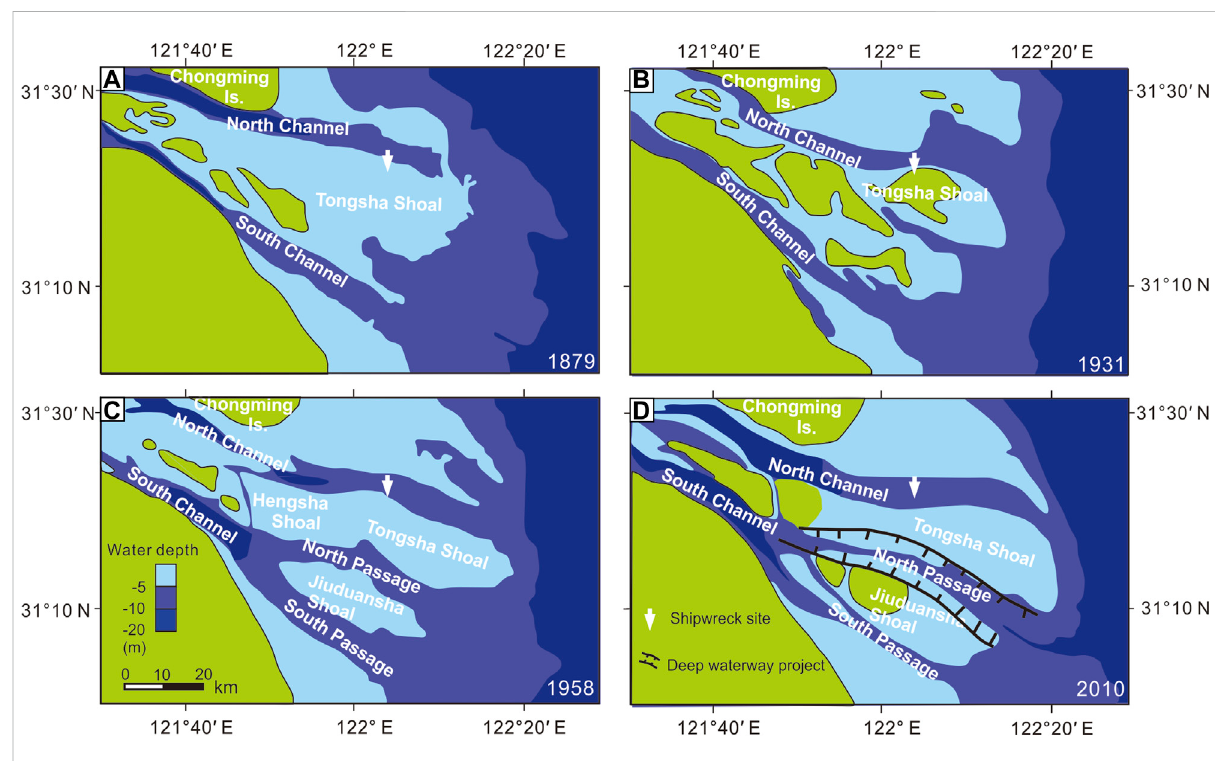
FIGURE 2 Historical marine charts showing morphological changes of the Yangtze River mouth from 1879 to 2010 CE (after Su and Fan,